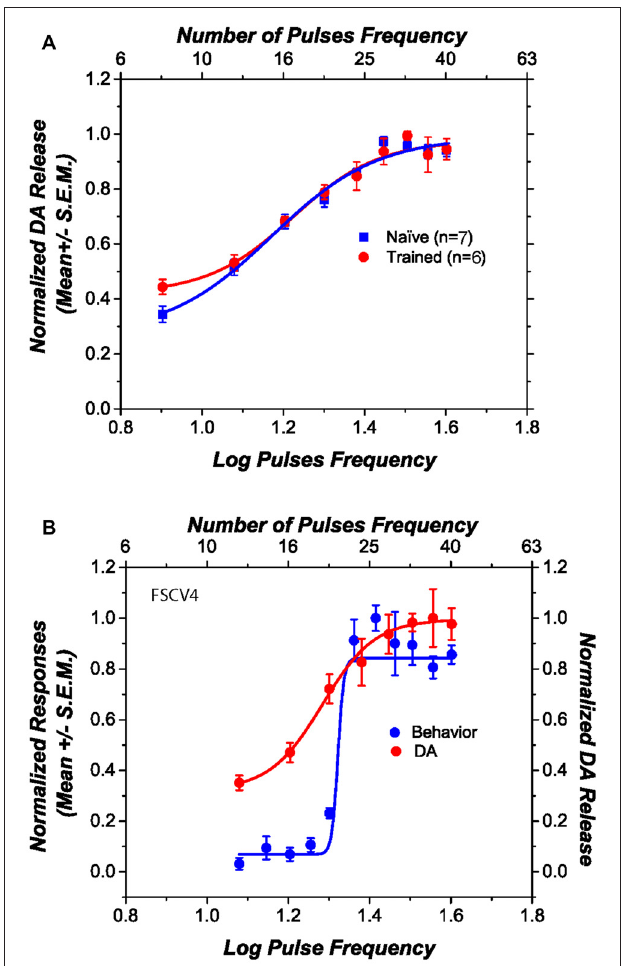
FIGURE 3 | Dopamine (DA) release induced by dorsal raphe (DR) stimulation, as a function of pulse frequency. (A) The DA release profile obtained from behaviorally trained and naïve subjects is very similar. (B) The relation between self-stimulation performance and stimulation-induced DA release in one representative subject. Although the slopes of the two curves differ, their midpoints fall at similar positions along the pulse-frequency axis.